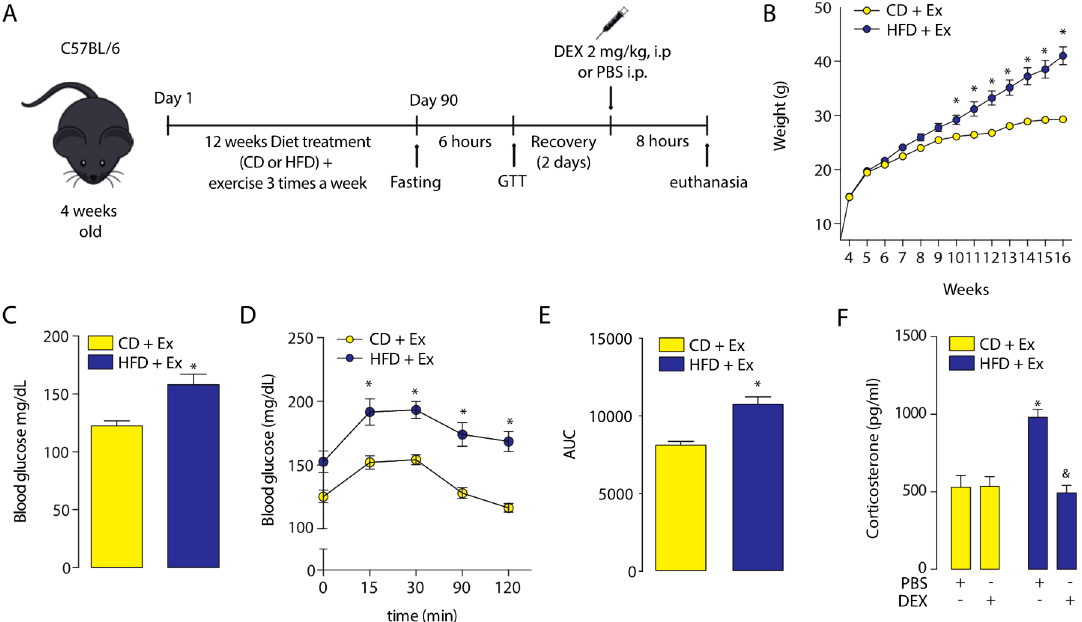
Figure 4. Effects of exercise on body weight, glucose homeostasis, and corticosterone plasma levels in normal and obese mice. ( A ) Study design. ( B ) Body weight. ( C ) Fasting glucose. ( D ) Glucose tolerance test (GTT). ( E ) GTT area under the curve (AUC). * p < 0.05, unpaired t -test. * p < 0.05, unpaired t -test. ( F ) Corticosterone plasma levels after a dexamethasone injection (DEX; 2 mg / Kg i.p.) or phosphate-buffered saline (PBS). n = 6 mice per condition. Two-way analysis of variance (ANOVA) was conducted, followed by Tukey’s post hoc test. * p < 0.05 vs. CD + PBS, & p < 0.05 vs. HFD + PBS. Values are expressed as mean ± standard error of mean.